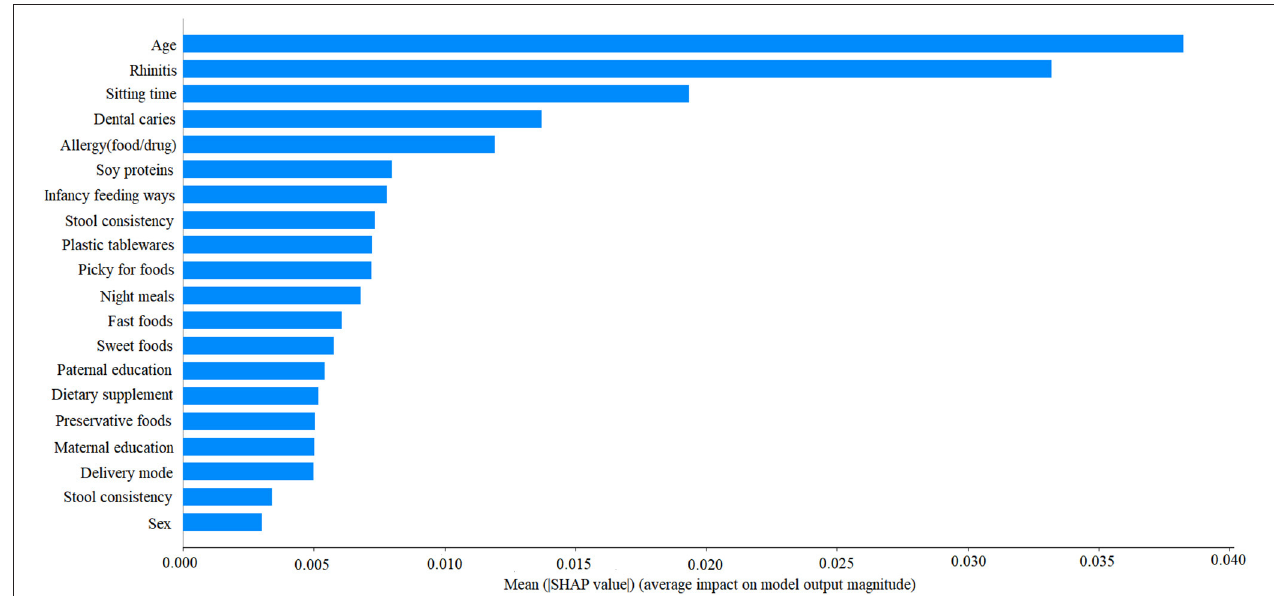
FIGURE 2 | The ranking importance of top 20 factors for lower respiratory tract infection.